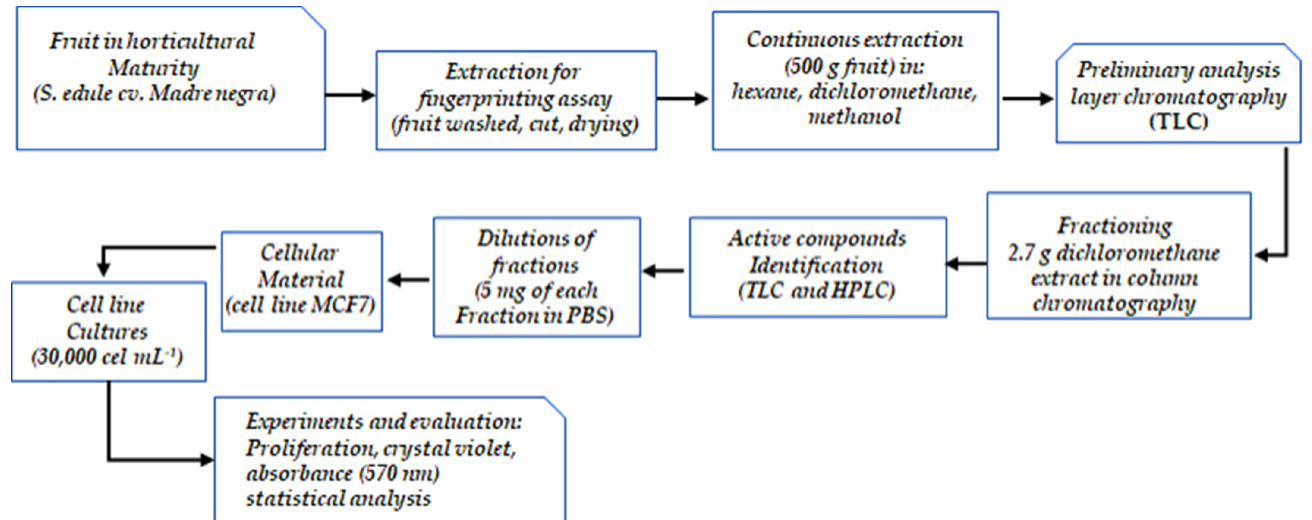
Figure 2. Flowchart of methods performed in the experimentation.